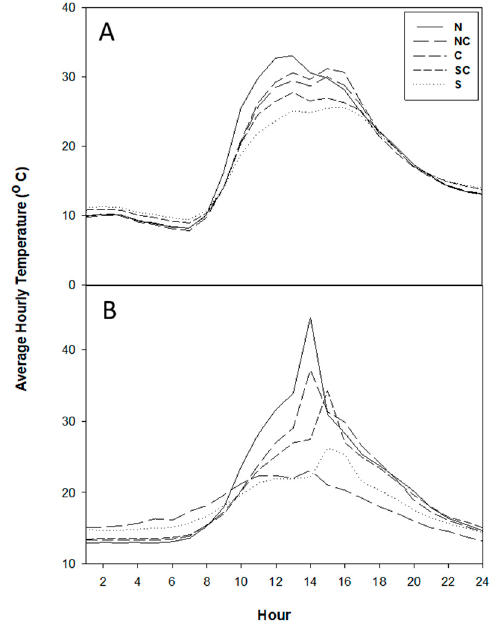
Figure 3. Temperature (averaged hourly) dynamics over 24 h of a day in gap positions, recorded 10 days before the burn day ( A ) and on the day of burn ( B ). Zero (0) hour represents 12 am (midnight). Positions are north(N), North Center (NC), Center (C), South Center (SC), and South (S).